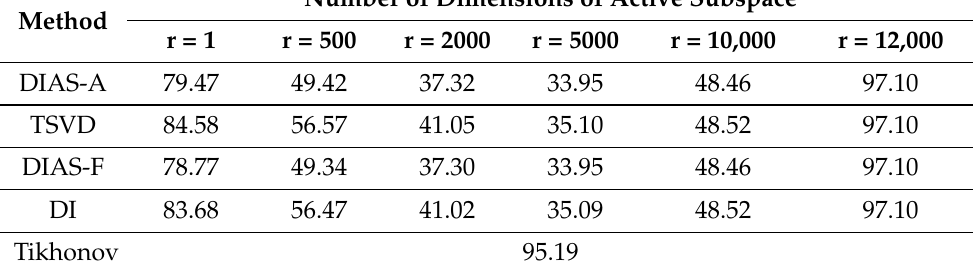
Table 8. Relative error (%) of inverse solutions by DIAS and Tikhonov regularization for underregu- larization case with α = 10 8 , noise level